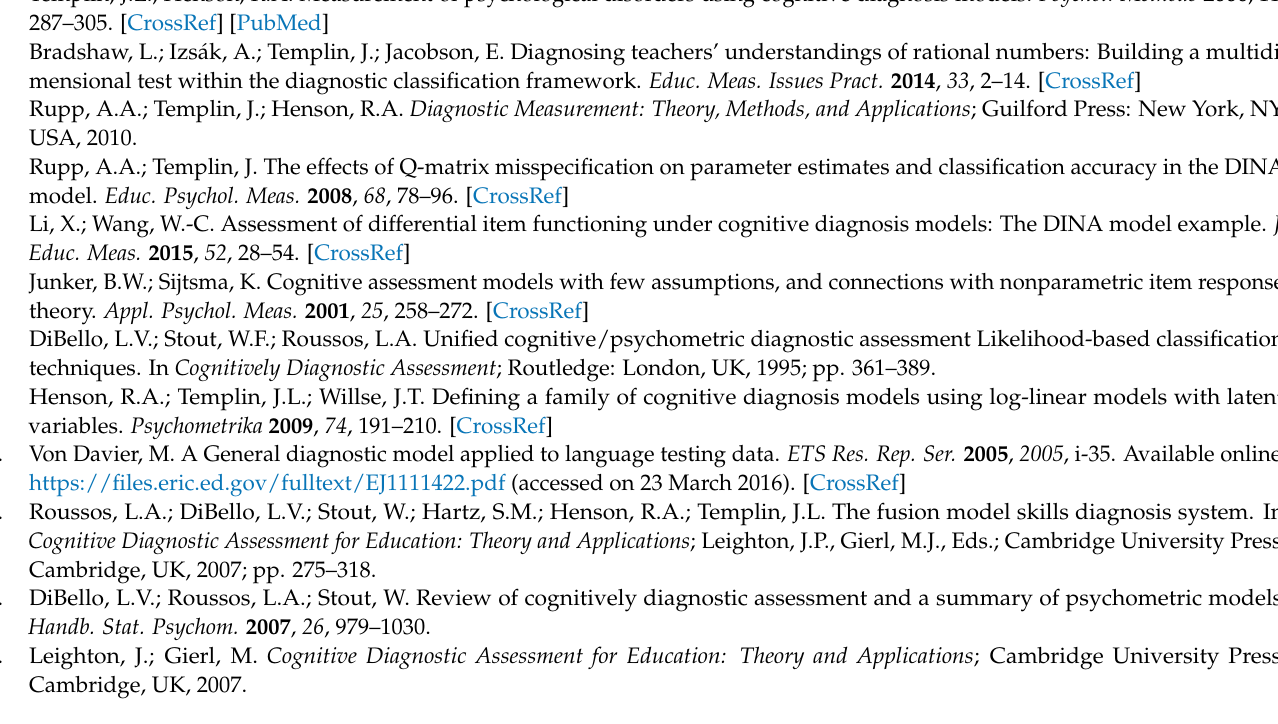
Figure S3: Bias of item parameter estimations under the MIXED missing